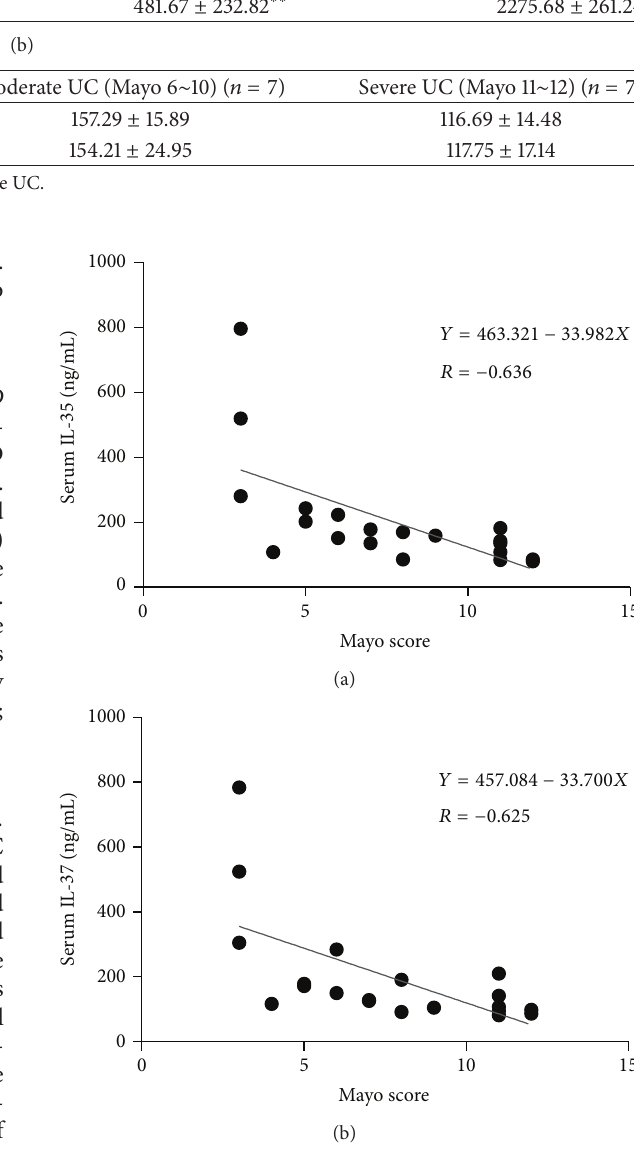
Figure 1: There was an intermediate inverse correlation between the Mayo score and serum IL-35 levels (a). IL-37 levels were moderately negatively correlated with Mayo score